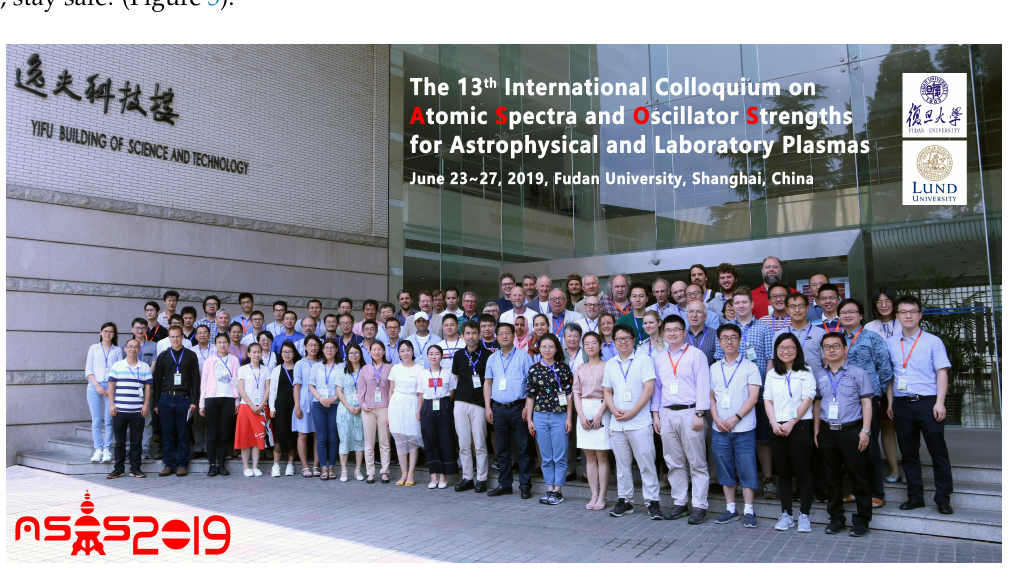
Figure 5. The conference photo of